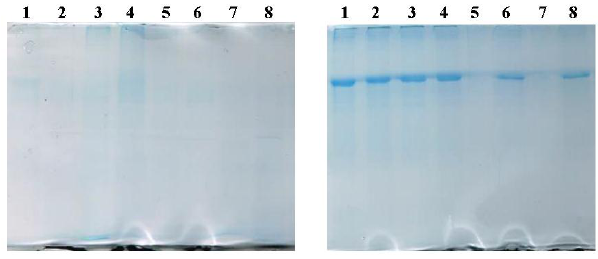
Figure 2. SDS-PAGE of: ( left ) LUVs and ( right ) MLVs after 24 h incubation with BSA at 37 °C. The order of the bands is from left to right: 1: Bare PC; 2: bare PC/Chol; 3: PEGylated-PC; 4: RGD-PC; 5: bare DMPC; 6: bare DMPC/Chol; 7: PEGylated-DMPC; and 8: RGD-DMPC.